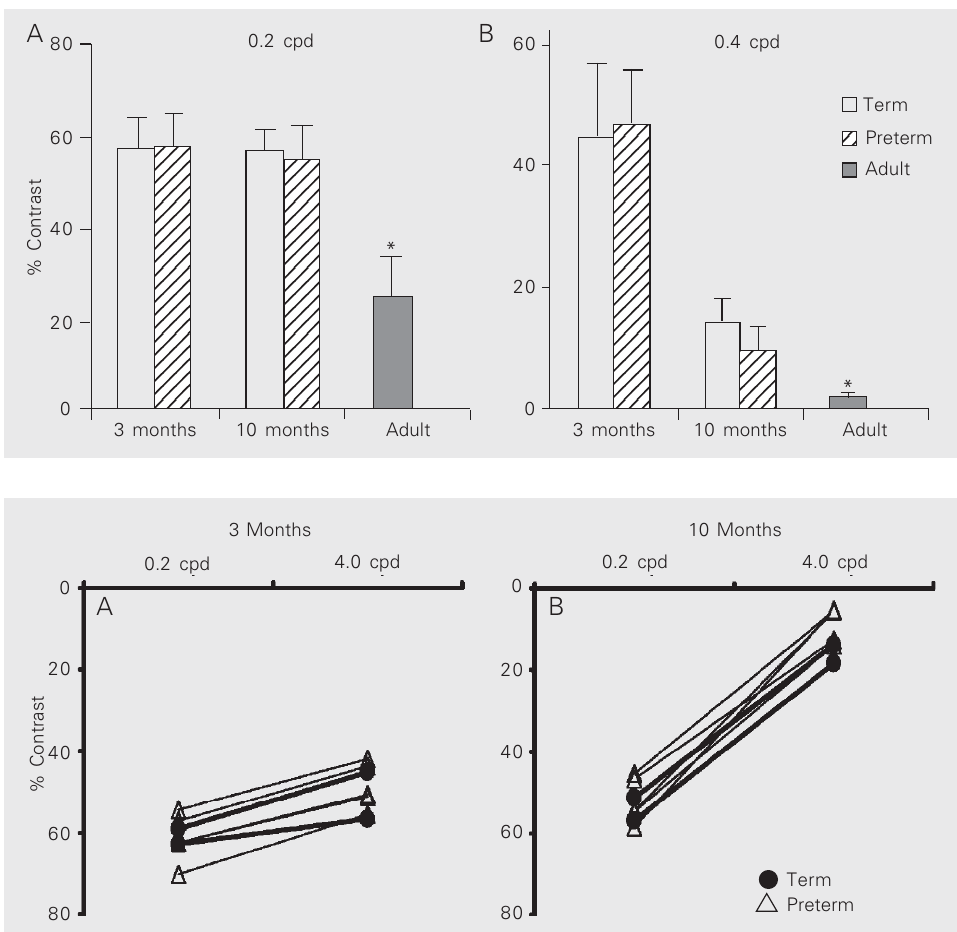
rather than from the direct and specific retino-geniculo-cortical visual pathways. After this period and coinciding with respon- sive smiling, the VEP consists of a short- to activity in the retino-geniculo-striate path- way (28,29). Long-latency responses are also present in children with delayed visual matura- tion and in children with cortical blindness.